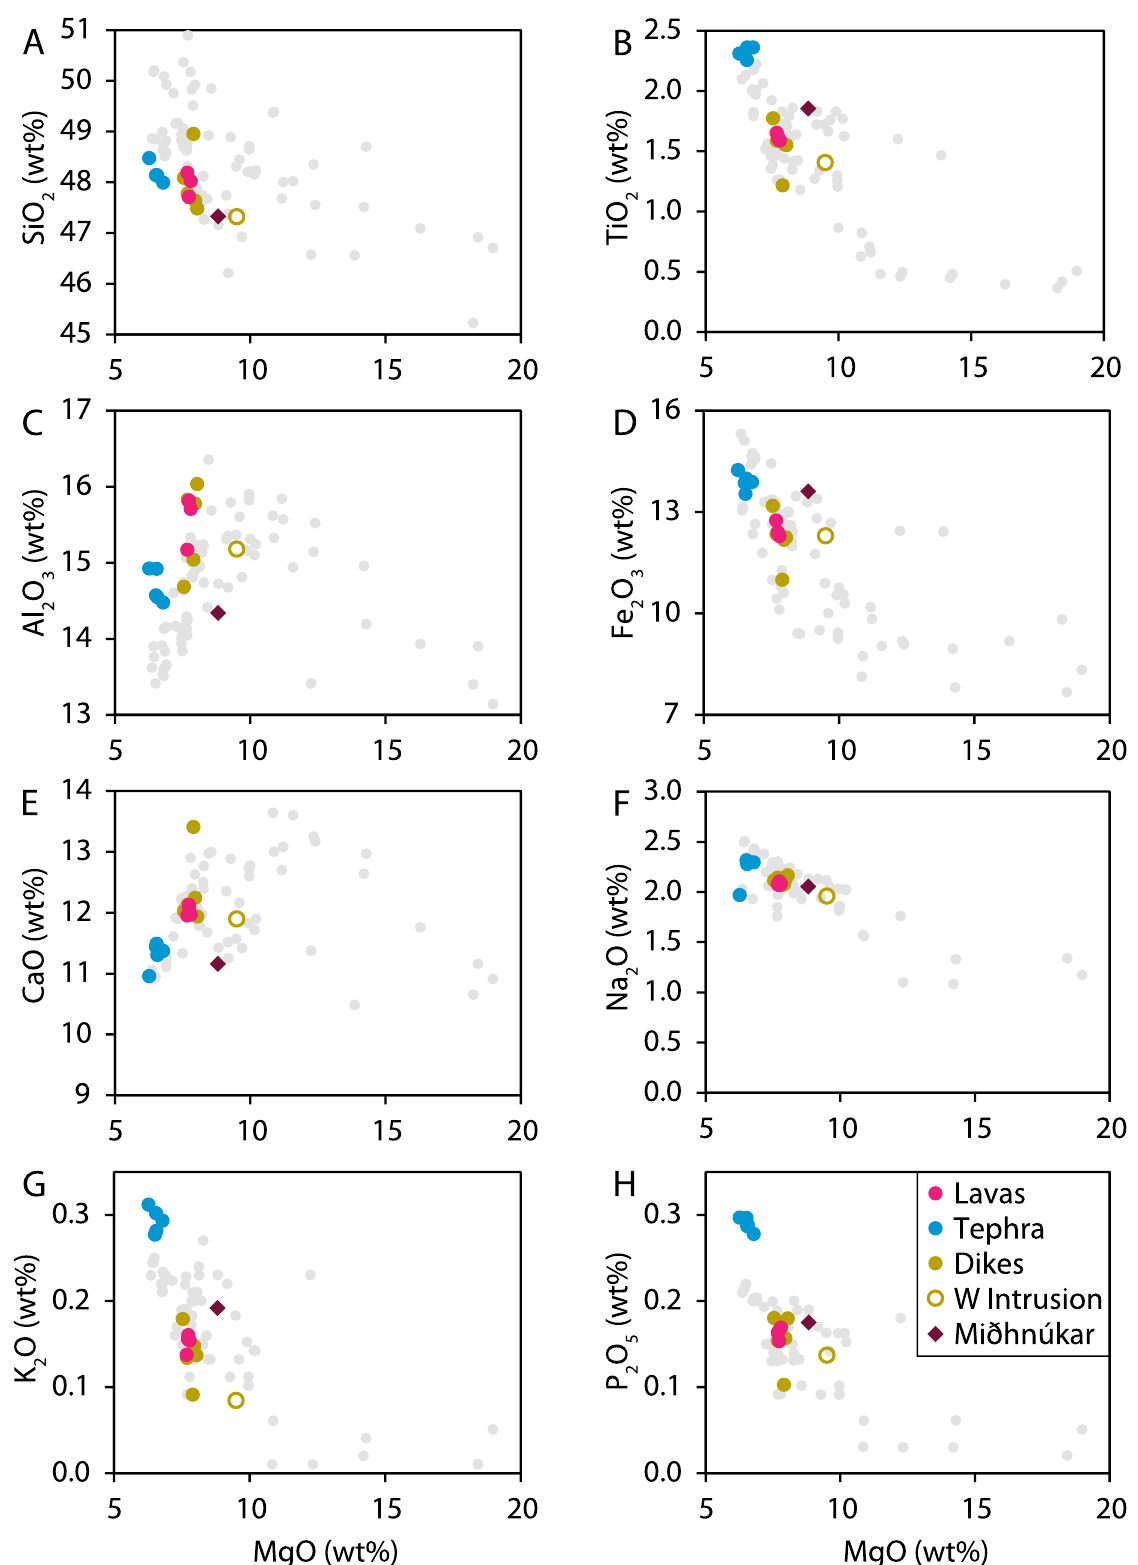
Figure 10: (Previous page.) Major element plots of MgO vs. SiO P O [G] for Thríhnúkagígur lavas, the tephra exposed in the cave, the dikes, the western wall intrusion, and Miðhnúkur. Gray 2 5 circles are published data for lavas on the Reykjanes Peninsula [Jakobsson et al. 1978; Gee et al. 1998; Kokfelt 2006; Peate et al. 2009; Koornneef et al.